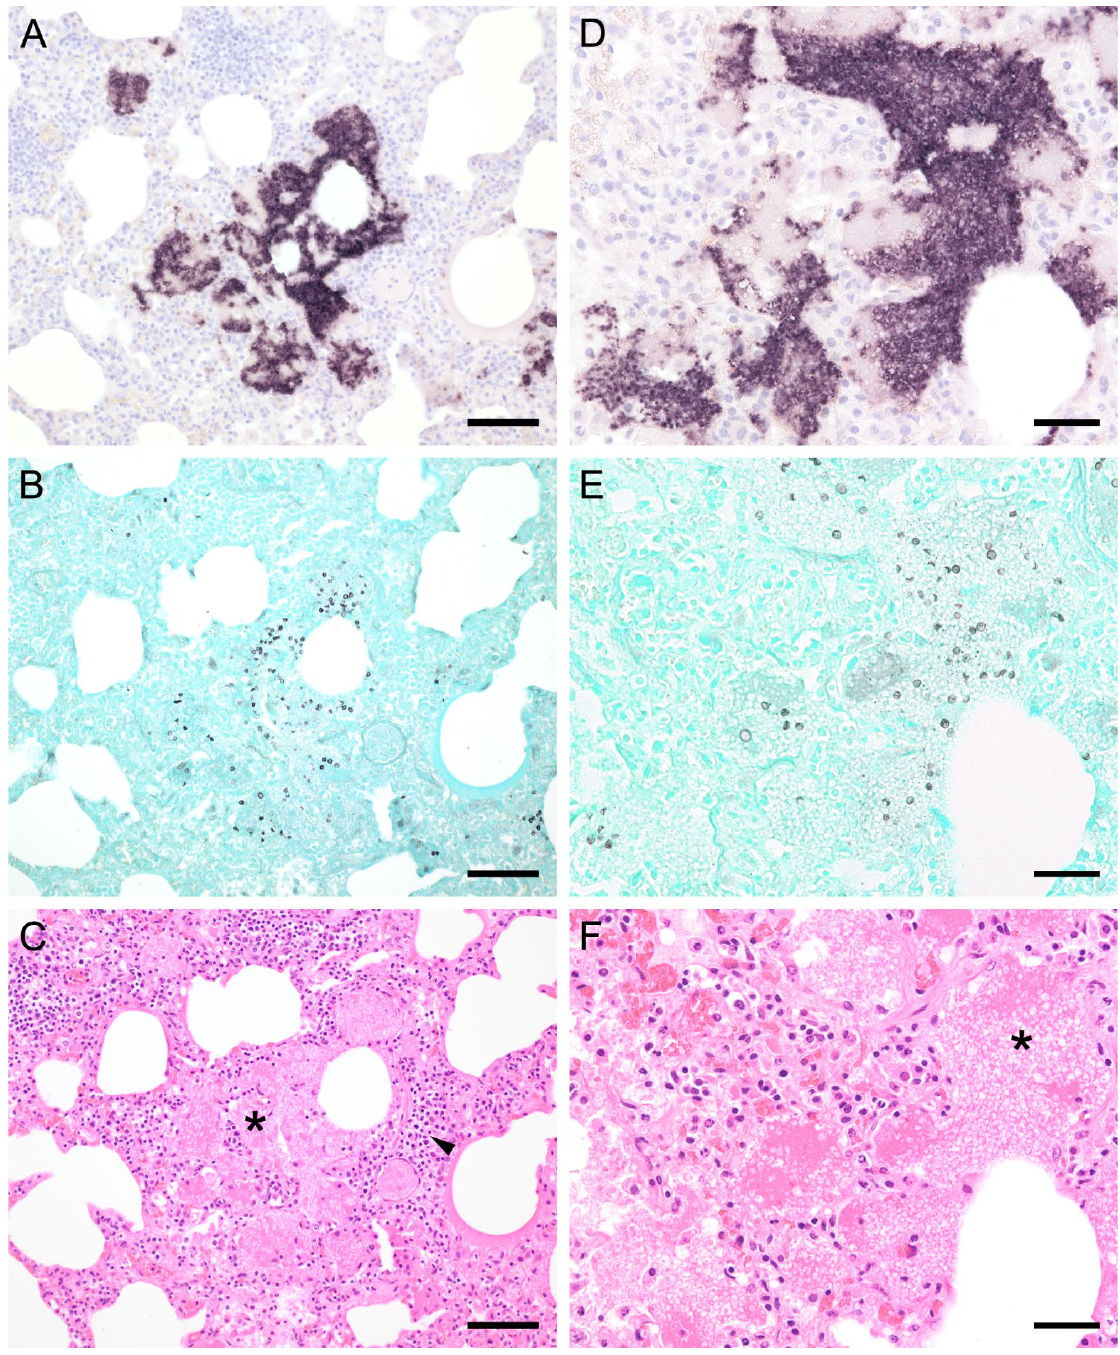
Figure 1. Adjacent sections from the same pig lung area of two different pigs with high loads of Pneumocystis spp. organisms are shown in comparison after ISH, GMS, and H&E staining. ( A ) ISH labels large clusters of Pneumocystis organisms. The ISH-positive areas are surrounded by Pneumo- cystis -free lung tissue. Bar = 80 µm; ( B ) GMS labels exclusively cystic forms that are less frequent. Bar = 80 µm; ( C ) H&E staining reveals an interstitial pneumonia with moderate lymphocytic infil- tration (arrowhead). Pneumocystis colonies are recognizable by their ‘honeycomb’ appearance (asterisk). Bar = 80 µ m; ( D ) Large parts of the alveolar spaces are filled with ISH-stained organisms due to proliferation of the fungus. Bar = 40 µ m; ( E ) The number of GMS-stained asci is small compared to that of unstained trophozoites. Bar = 40 µ m; ( F ) Despite the high Pneumocystis concentration (asterisk), the pulmonary architecture is well preserved. Bar = 40 µ